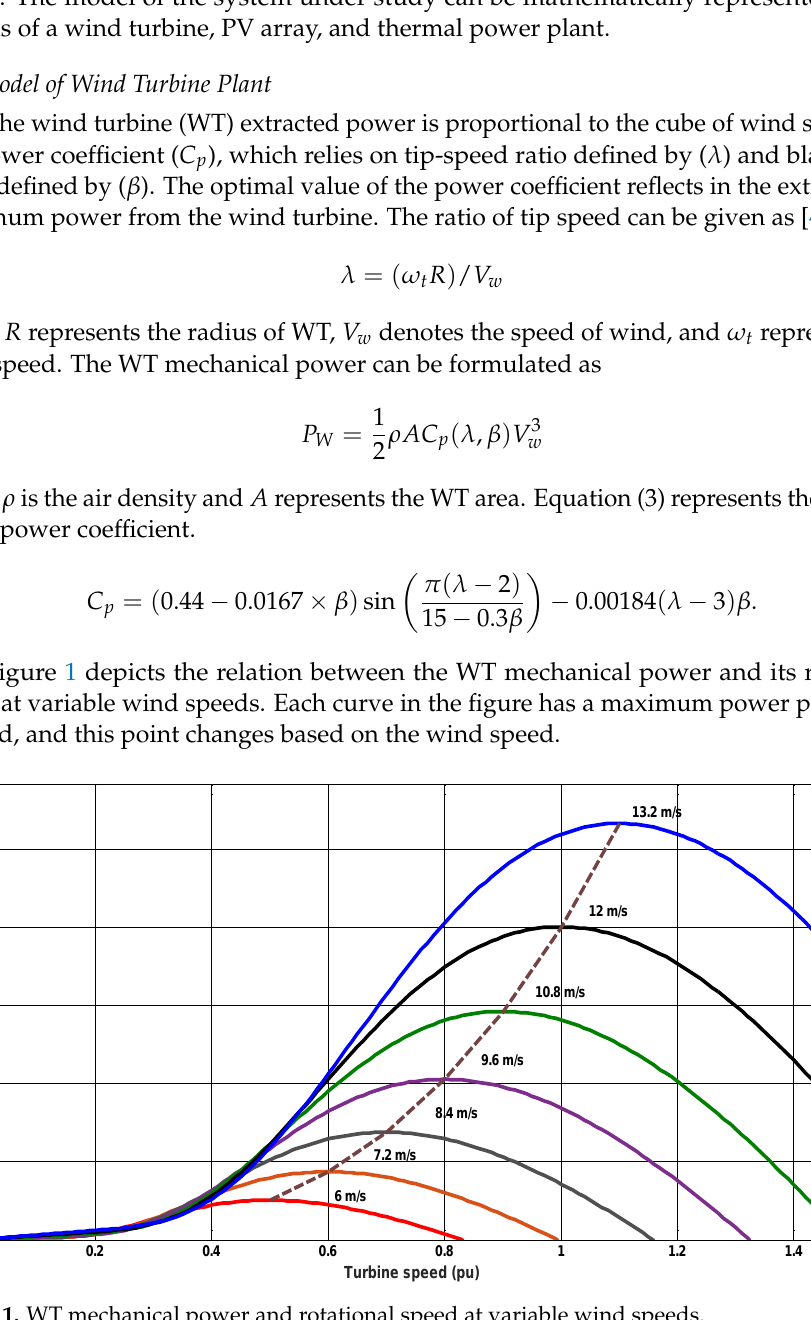
Figure 1. WT mechanical power and rotational speed at variable wind